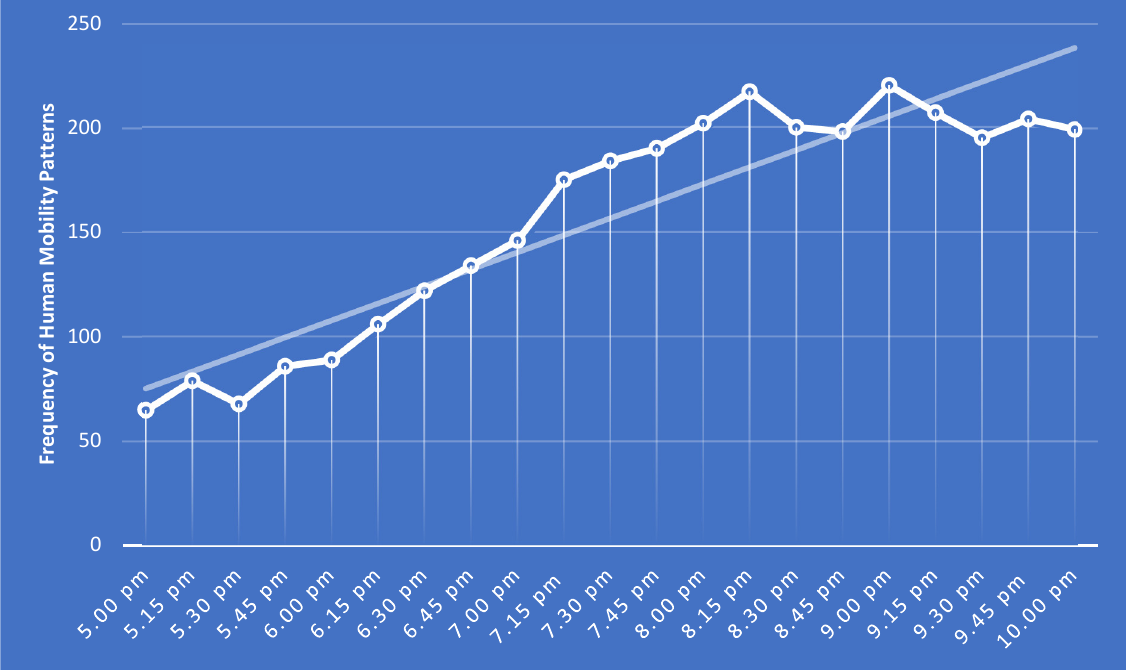
Figure 10. The correlation between different time periods and the frequency of human mobility patterns in the study area.